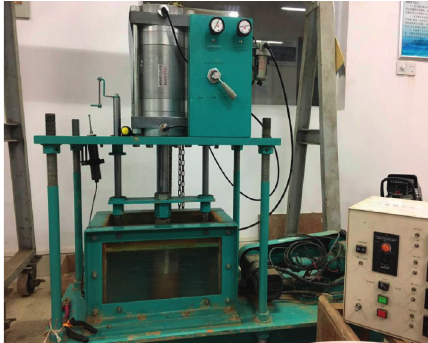
Figure 5: Apparatus of loading and monitoring system.